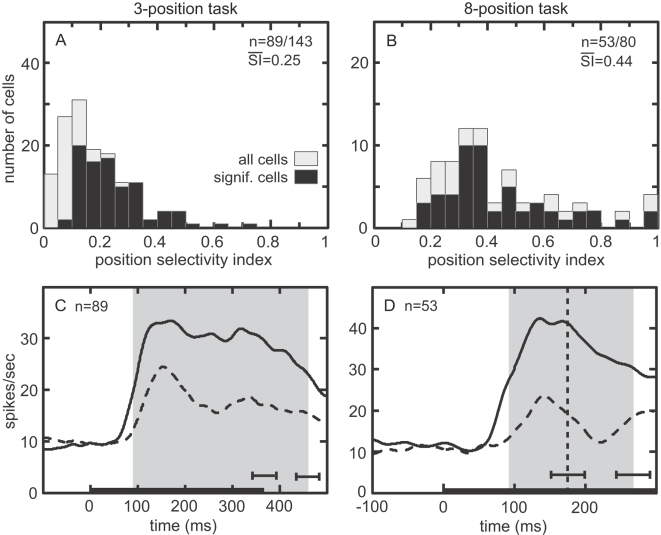
Retinal position effect showing stimulus response changes as a function of retinal position.A. Distribution of position selectivity index (SI) for 3-position task. Larger values indicate greater selectivity. Mean SI for significant cells is indicated. B. Distribution of position selectivity index for 8-position task. C. Time course of responses at best and worst locations for 3-position task, averaged over all significant cells. Data included from the most effective shape for each cell. Trials were aligned on stimulus onset (zero time). Gray zone indicates stimulus period shifted by neural latency, the time epoch used for ANOVA. Horizontal error bars shows standard deviation of stimulus-off time and of stimulus-off time shifted by neural latency. Curves smoothed using a 10 ms Gaussian kernel. D. Time course of responses at best and worst positions for 8-position task. Gray zone indicates the period from stimulus start until saccade onset shifted by neural latency, used for ANOVA. Horizontal error bars indicate standard deviation of saccade onset time and of saccade onset time shifted by neural latency.